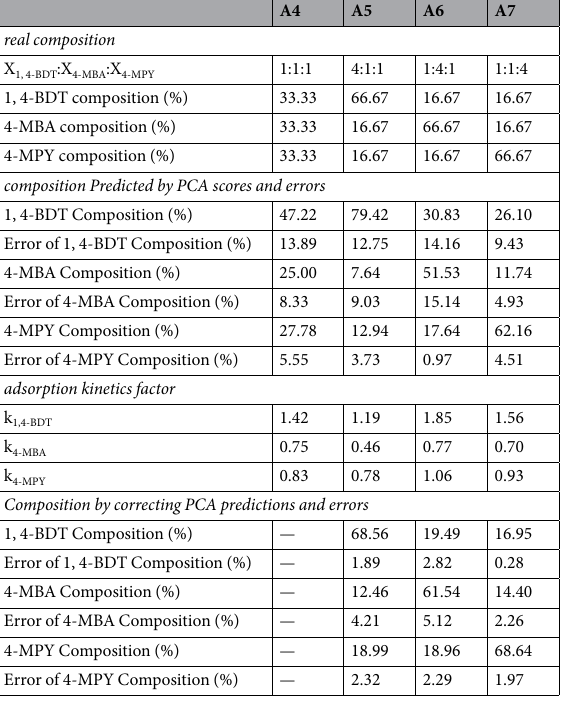
Table 2. Real composition in solution, composition predicted by PCA scores and errors, adsorption kinetics factor for each component, corrected PCA predictions, and errors for ternary sample A4 to